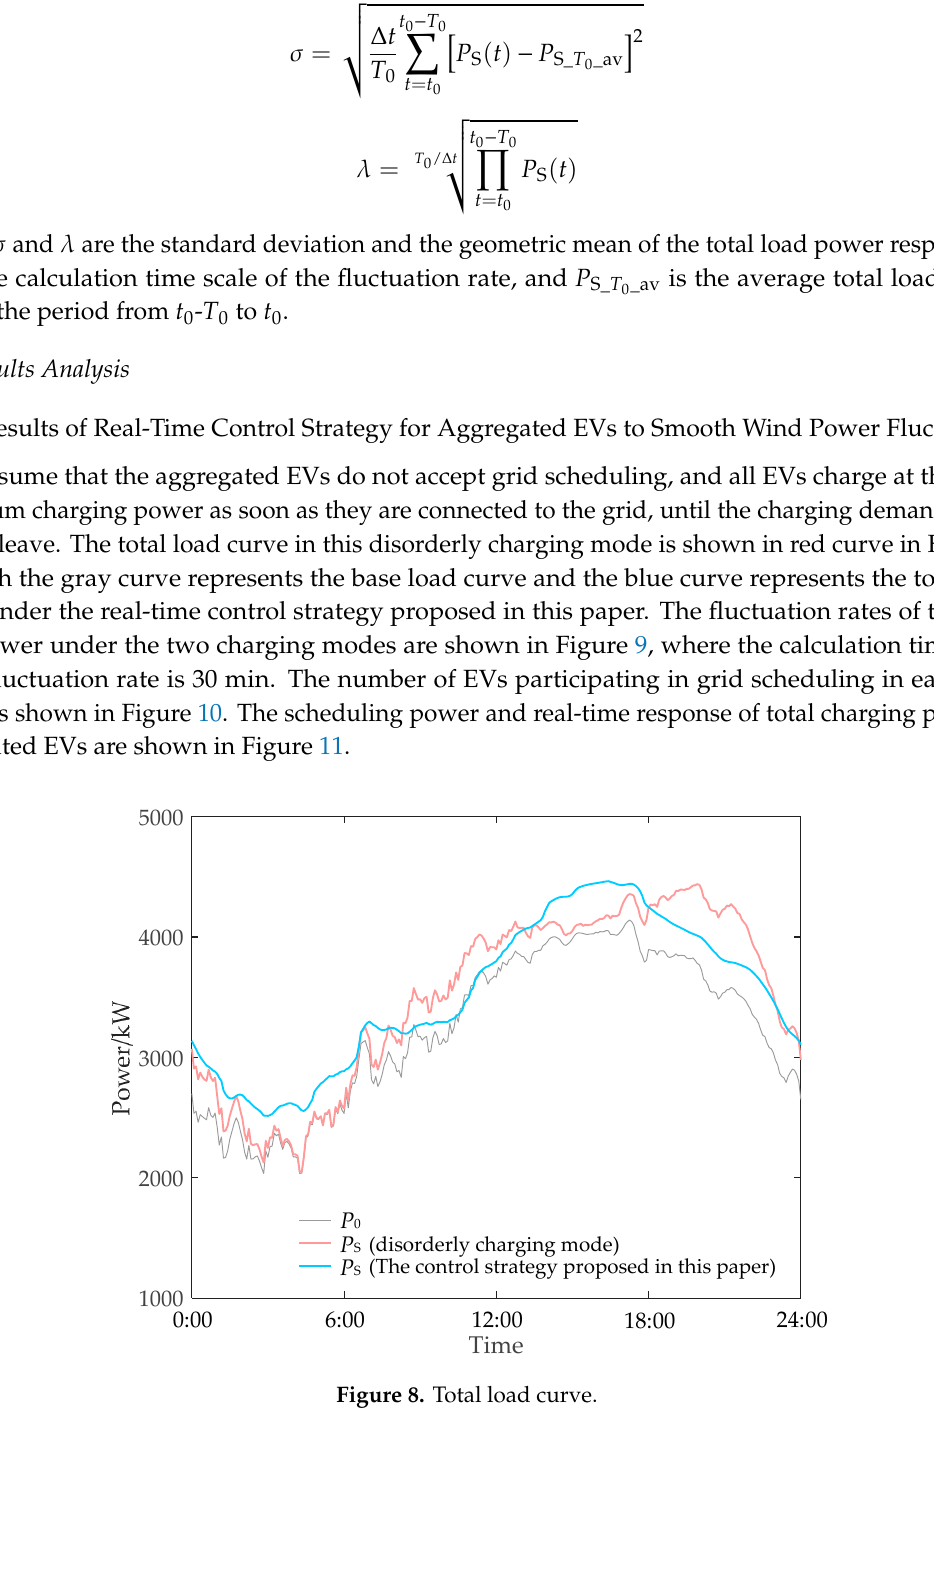
Figure 9. Total load power fluctuation rate.